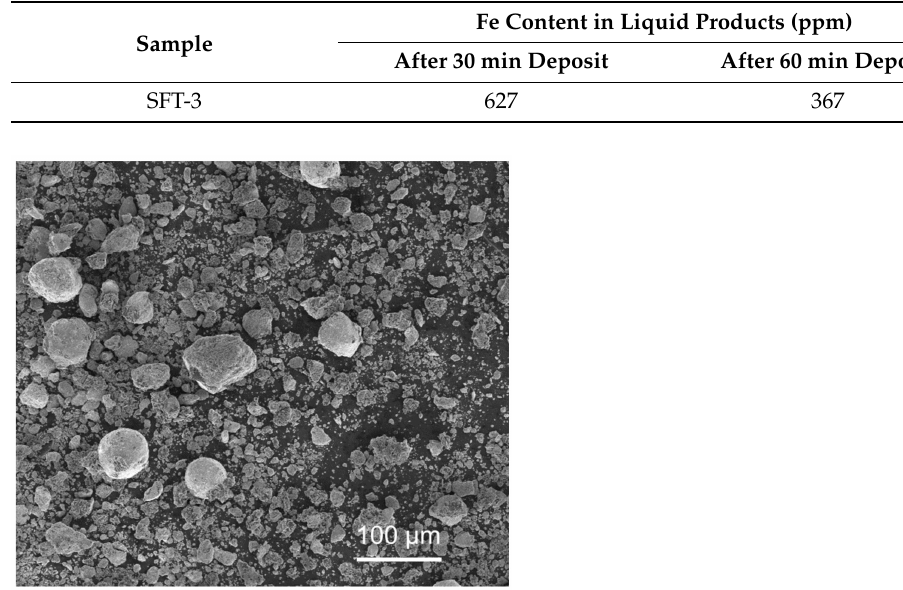
Table 4. Fe content in liquid products of SFT-3.